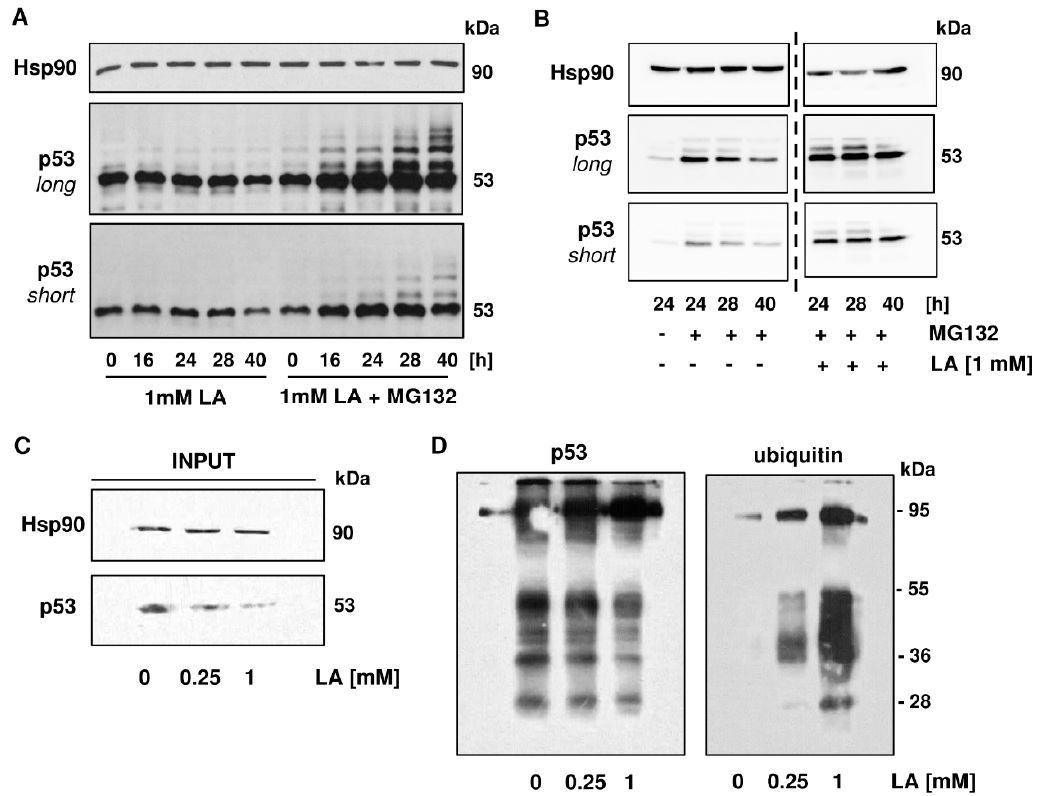
Figure 6. LA causes enhanced ubiquitination of p53. ( A ) Enhanced ubiquitination as shown in HCT116 cells over a time period of 16 to 40 h using co-treatment with the proteasome inhibitor MG132 (10 µ M), which was supplemented 16 h after treatment with 1 mM of LA. Cells were harvested at indicated time points and underwent western blot analysis. ( B ) Higher levels of p53 ubiquitination in HCT116 cells upon co-treatment of LA with MG132 after 24, 28, and 40 h with the corresponding MG132-control. Experiment was conducted as described in A. Samples were analyzed on the same blot membrane and cut for better visualization (dashed line). ( C , D ) Co-immunoprecipitation of p53 in HCT116 after 48 h of LA-treatment. EtOH served as solvent control (0 mM LA). The left panel describes input for co-immunoprecipitation with rabbit polyclonal p53-antibody. The right panel represents output for mouse monoclonal p53-antibody and mouse monoclonal ubiquitin-antibody.